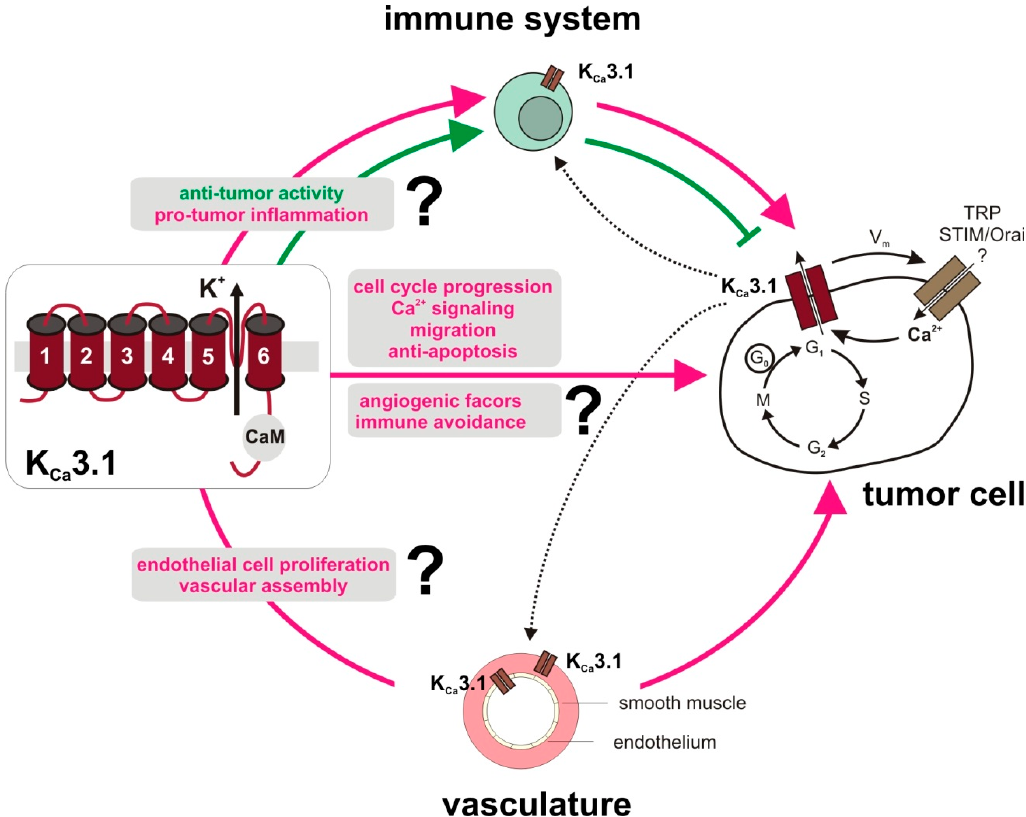
Figure 3. Role of the K Ca 3.1 channel in tumor-associated cells. Tumors from different entities and various microenvironmental cell types, i.e., immune cells, vasculature, fibroblasts (not shown) express functional K Ca 3.1 channels. Physiological roles and tumor behaviors of K Ca 3.1 are cell type-dependent, but involve proliferation, migration and cancer progression. K Ca 3.1 channel expression seems to be a crucial determinant of cancer risk and, in established cancers, K Ca 3.1 upregulation at the end of G 1 phase of the cell cycle was seen in various tumor cell types [36] . By its interaction with [Ca 2+ ] i via its constitutively bound calmodulin (CaM), with other ion channels such as TRP or STIM/Orai, with changes in the membrane potential (V m ), and with apoptotic pathways, K Ca 3.1 may further contribute to aberrant tumor cell signaling. Beyond that, tumor-promoting K Ca 3.1 activity in stromal cells has been described. Several studies find evidence for K Ca 3.1 expression in endothelial and in activated smooth muscle cells of the vasculature pointing to its role in tumor angiogenesis and/or vasculogenesis. Moreover, growth factor signaling was linked to K Ca 3.1 in fibroblasts to promote epithelial-mesenchymal transition in breast cancer (not depicted) [84] . Proper activation and function of various immune cell subsets requires K Ca 3.1. Therefore, perturbed K Ca 3.1 signaling may prevent cancer progression and disturb e.g., the immune cell´s pro-angiogenic program, but also its activity to recognize and eliminate tumor cells. Apparently, the impact of a tumor and stromal versus immune cell K Ca 3.1 inhibition on tumor progression and therapy success and thus also interaction between the different cell types, as indicated by dotted lanes, requires further investigations.